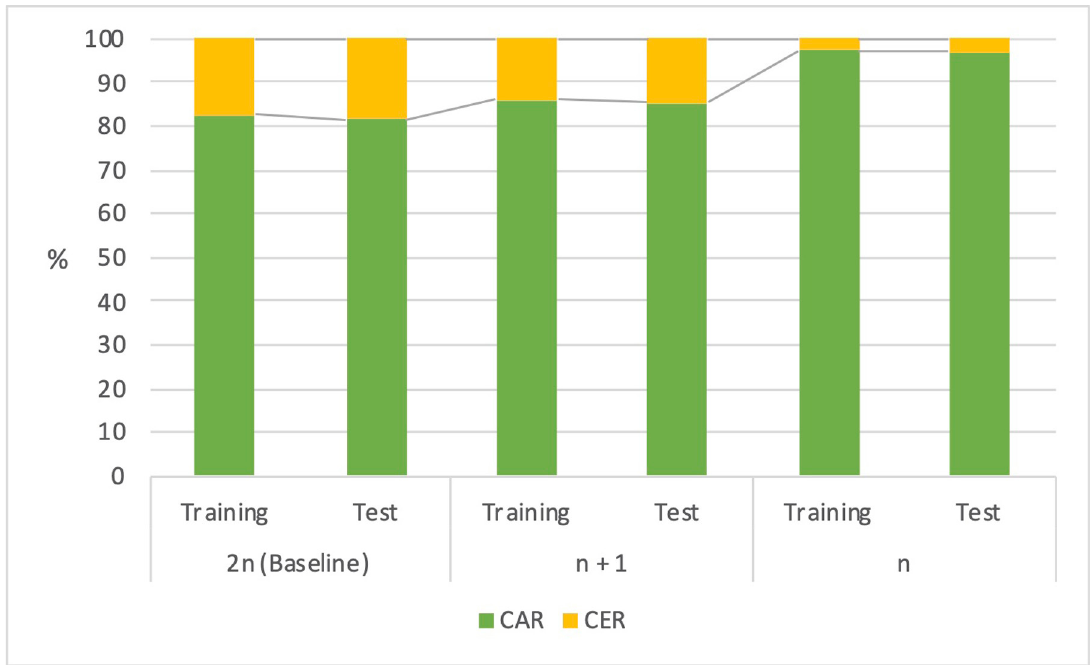
Figure 7: Overall Composite Accuracy and Error rates (summarized in Table